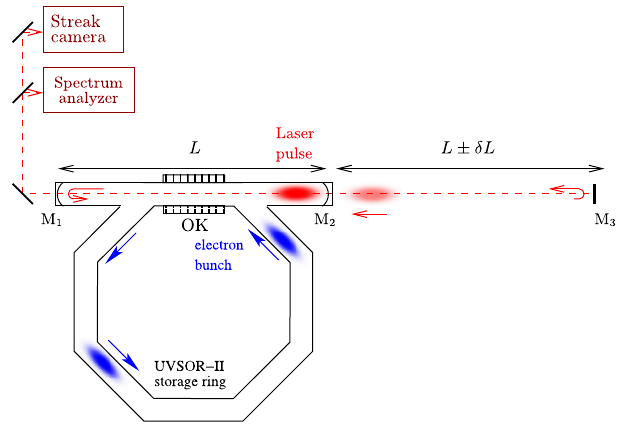
FIG. 1. Experimental setup. The feedback mirror is placed outside the FEL cavity at distance L þ (cid:2)L , where L is the cavity length (13.3 m). The feedback mirror position can be changed allowing one to produce a positive or negative delay (cid:2) (cid:2)L . The other FEL output is monitored using a double sweep streak camera and a real time spectrum analyzer. OK is the optical klystron. M 2 is the output coupler (with 0.4% transmission, and 6 m radius of curvature). M 1 is a high reflection mirror (with 8 m radius of curvature). M 3 is a plane highly reflecting feedback mirror.